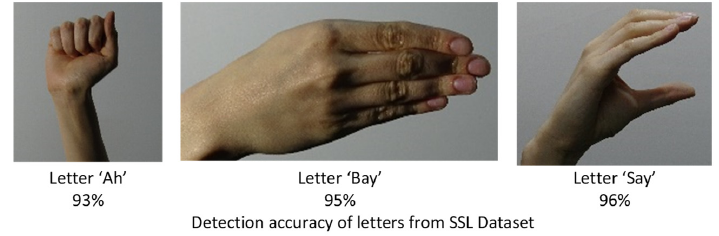
Figure 12. Processing hand gestures (SSL dataset).